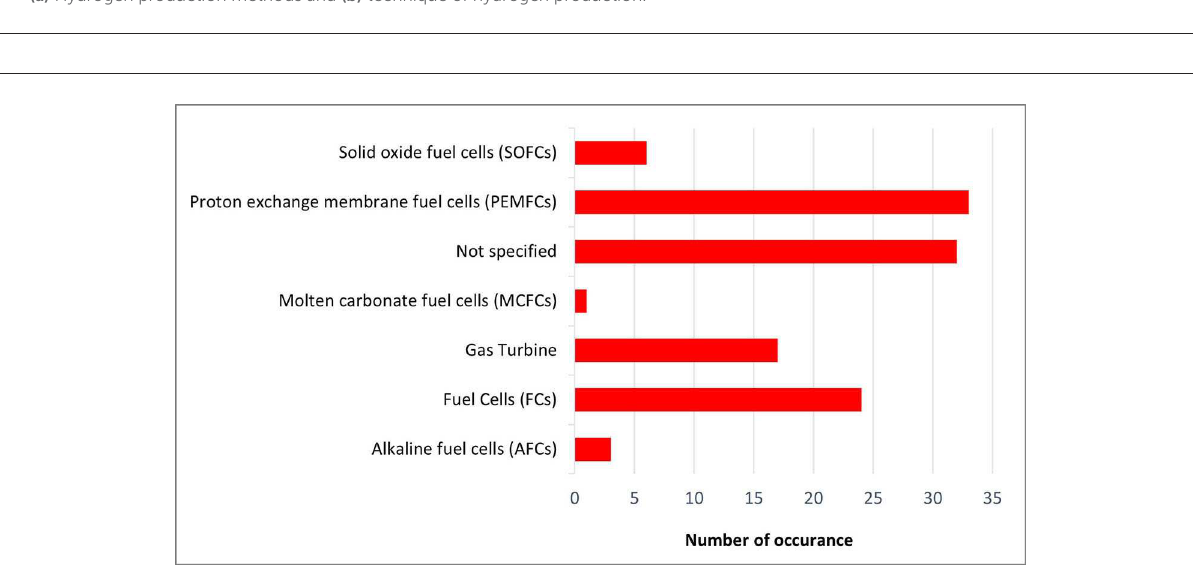
FIGURE6 Hydrogen power